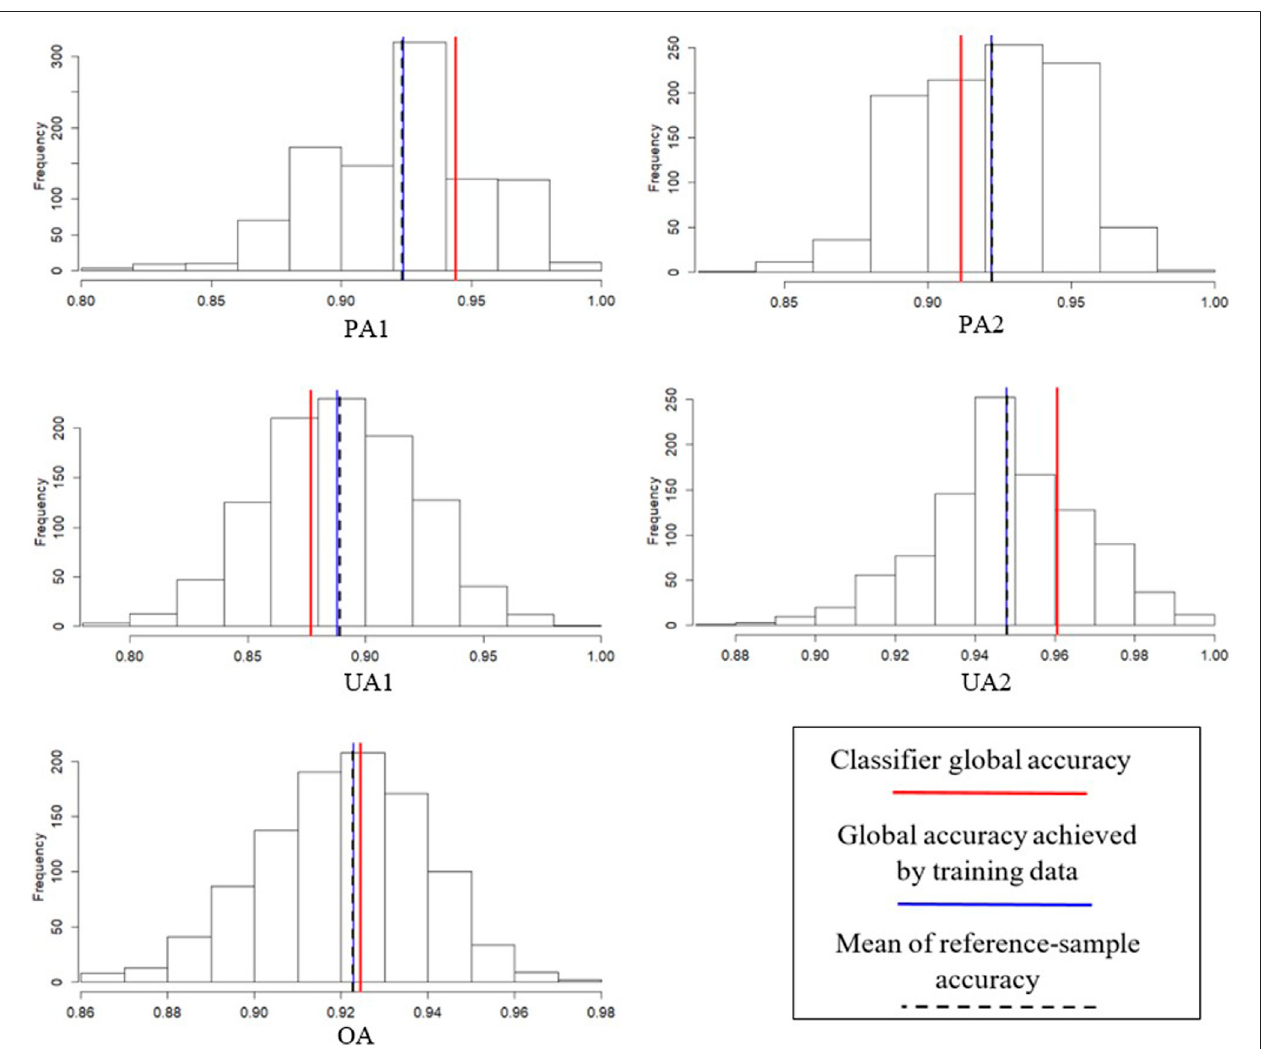
FIGURE 2 | Histograms of different reference sample accuracies (based on 1,000 sets of reference samples) with respect to a given training sample.